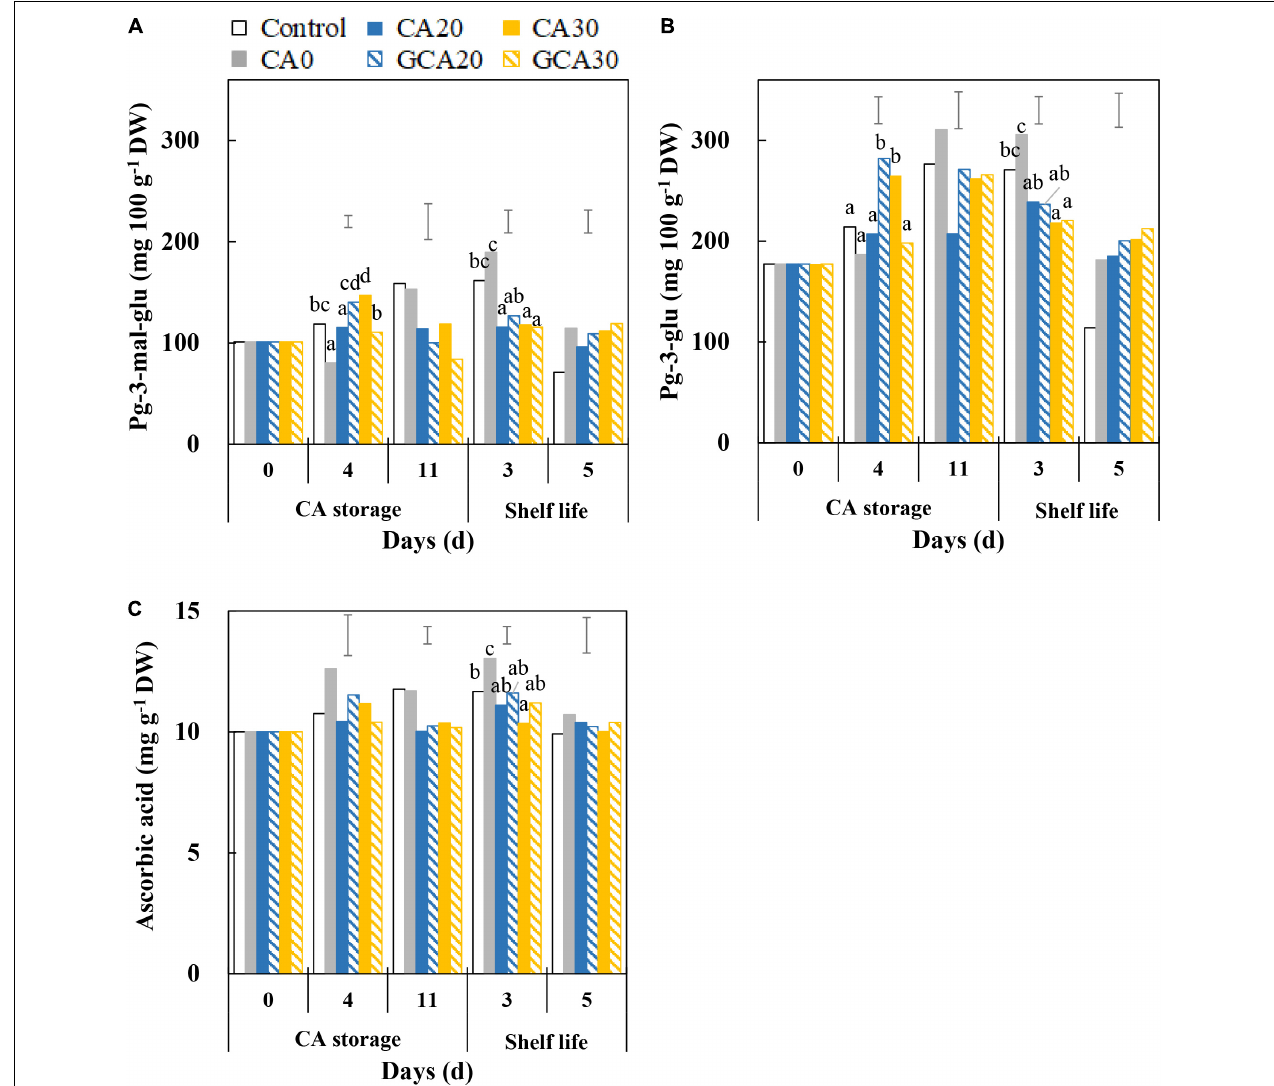
FIGURE 6 | Anthocyanin and ascorbic acid content of “Arabella” strawberry fruit during CA storage and shelf life. (A) Pelargonidin-3-malonyl glucoside, (B) pelargonidin-3-glucoside, and (C) ascorbic acid during CA storage at 5 ◦ C and ∼ 100% relative humidity and subsequent shelf life at 12 ◦ C and ∼ 95% relative humidity in ambient atmosphere. As a control condition, 21 kPa O 2 and 0 kPa CO 2 were used. Data represent means of 2 blocks ( n = 2; each block being a pooled sample of 20 replicated fruit). The error bars represent the standard error of means. Different letters denote significant differences according to Fisher’s protected LSD test ( α =